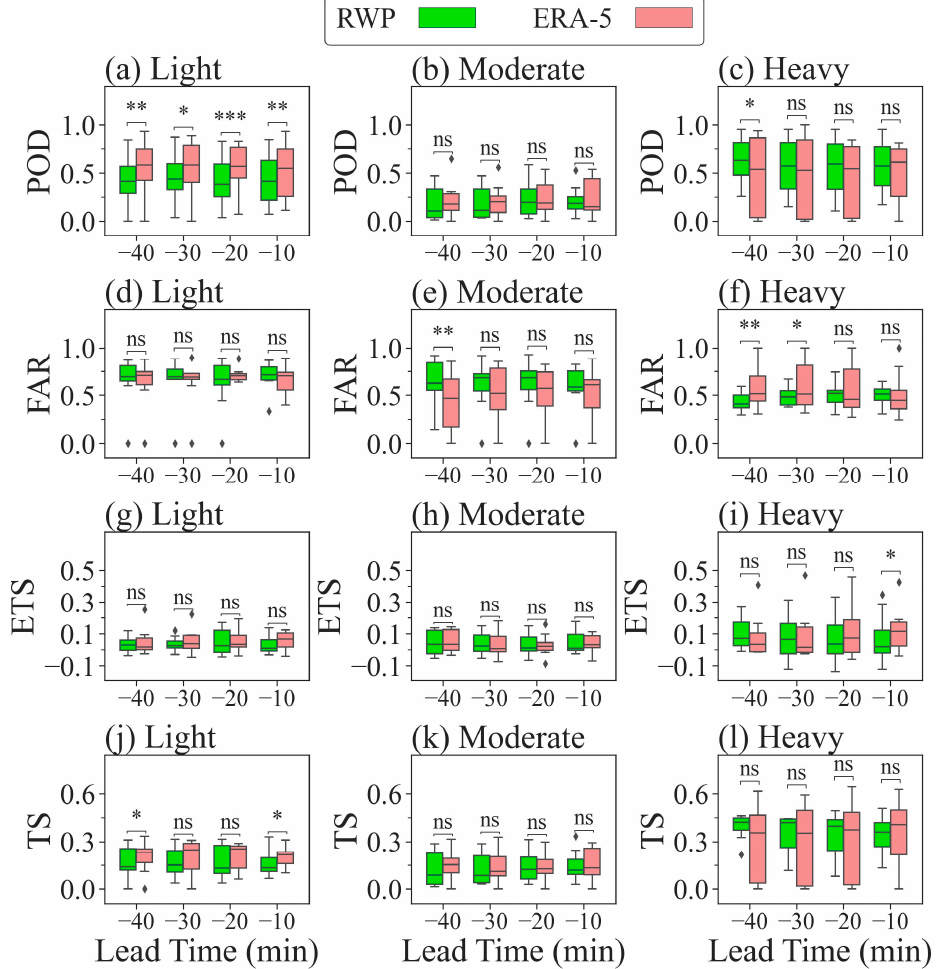
Figure 12. The same as Figure 9 but for the results of the rainfall grade forecast. * and ** above the box plot represents statistical significance passing the 95% and 99% confidence level, whereas “ns” represents no statistical significance, and outliers are indicated by black dots.